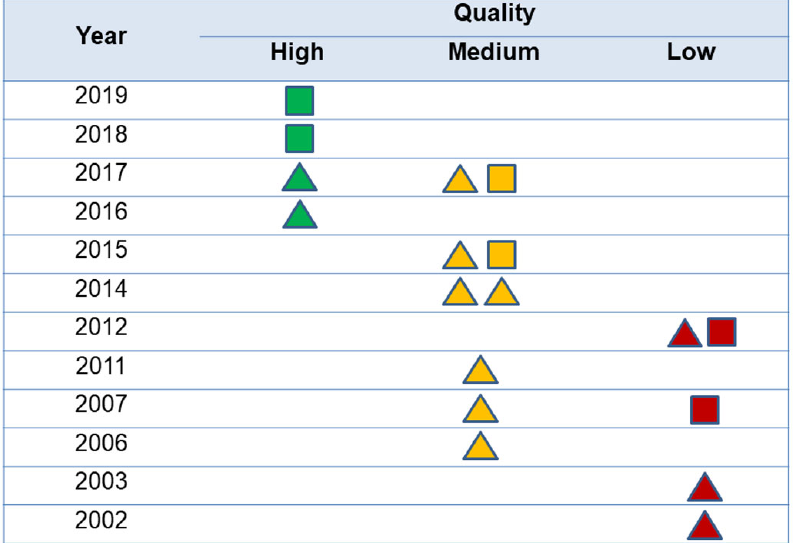
Figure 2. Quality of the studies according to the publication year. The triangles represent cohort studies and the squares, case ‐ control studies. The color represents quality of the studies according to Newcastle ‐ Ottawa scale.